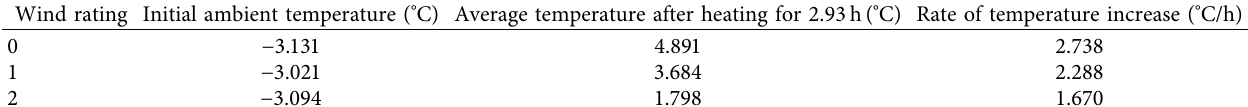
Table 9: Rate of the temperature increase of the specimen surface at different wind levels.